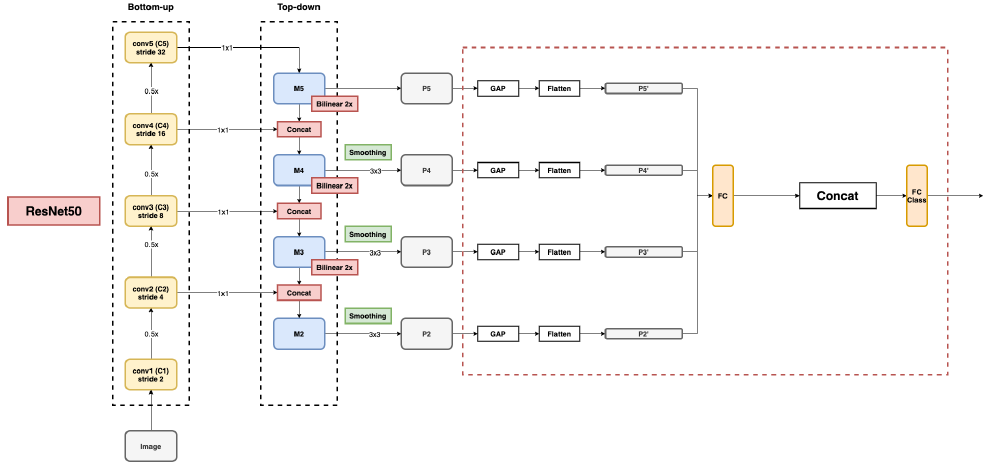
Figure 4. The architecture of the binary classifier extending Resnet50with FPN